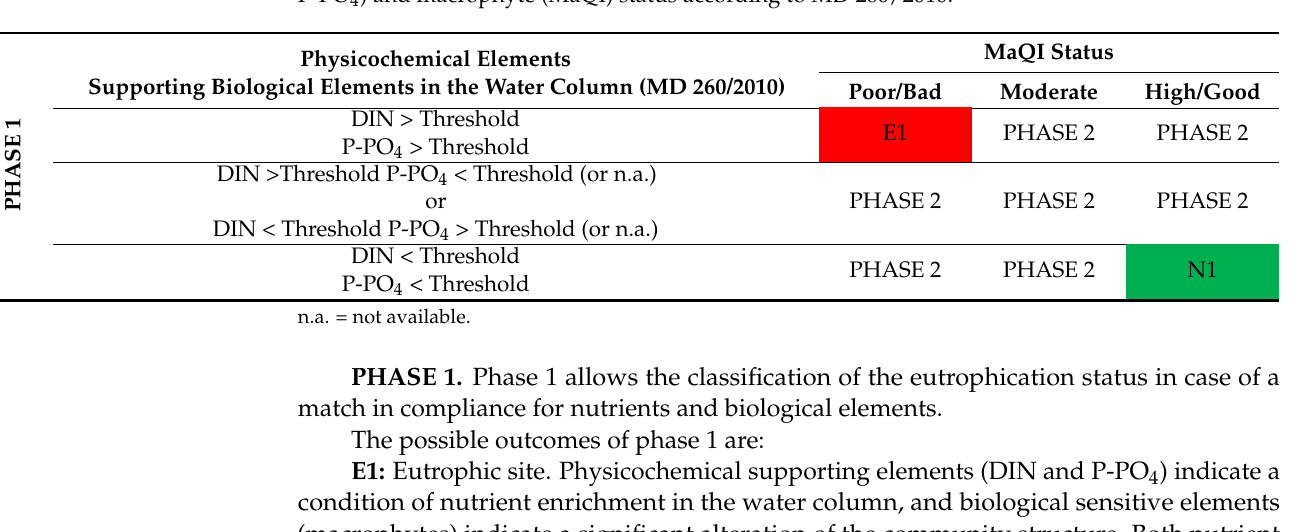
Table 2. Application of TWEAM in phase 1 and possible outcomes: integration of nutrients (DIN and P-PO 4 ) and macrophyte (MaQI) status according to MD